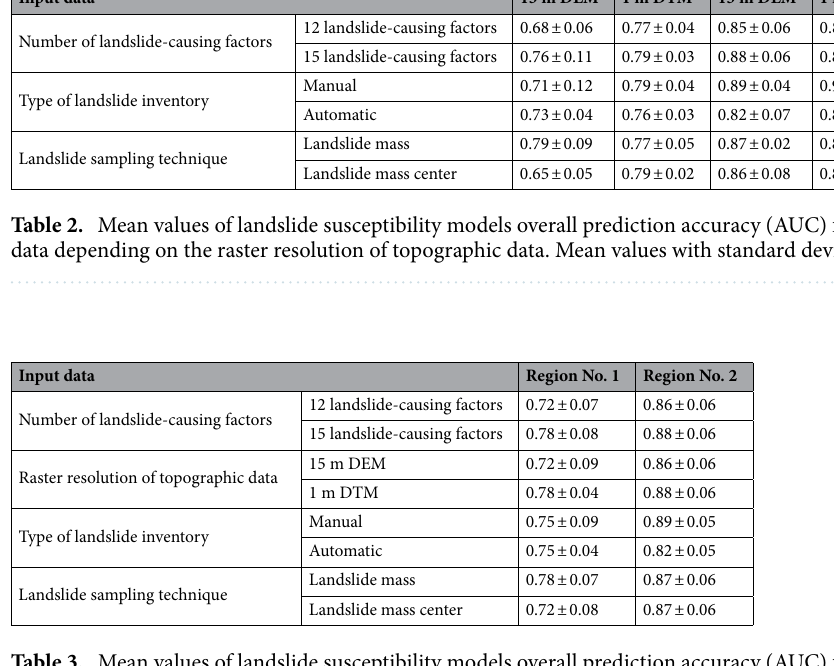
Table 3. Mean values of landslide susceptibility models overall prediction accuracy (AUC) for different input data. Mean values with standard